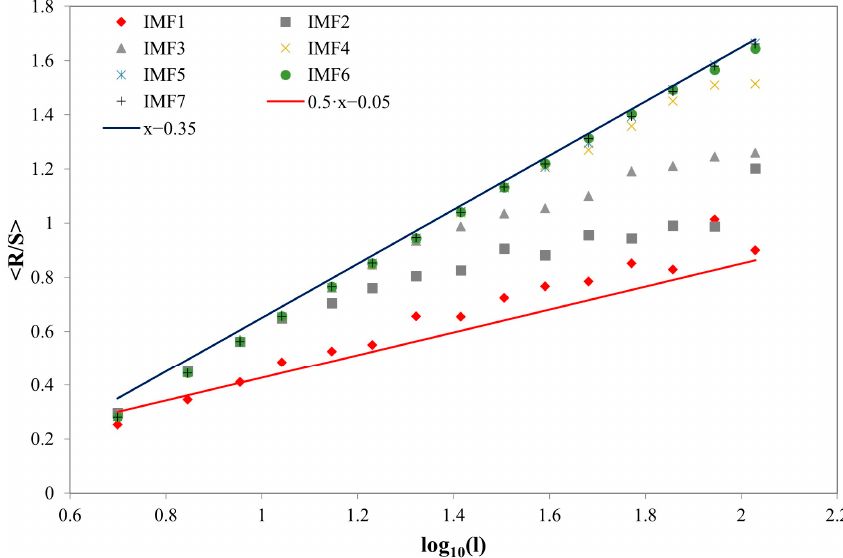
Figure 8. Hurst analysis for the detrended reconstructed humification timeseries.